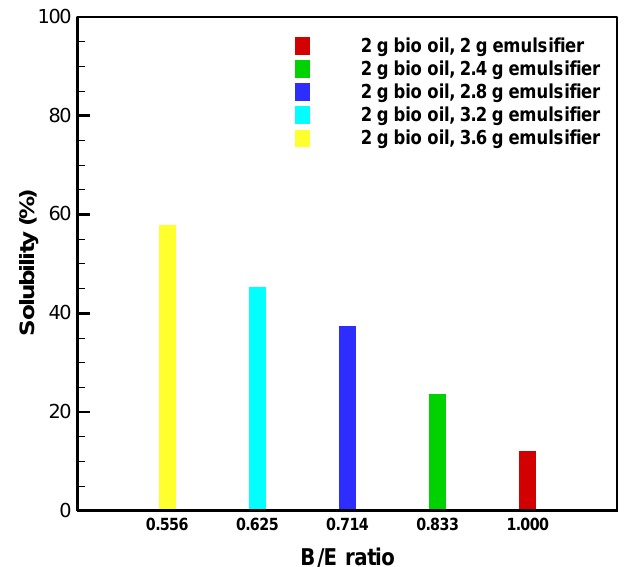
Figure 5. The solubility of the emulsions with different B/E ratios (2 g bio-oil) after 7 days .